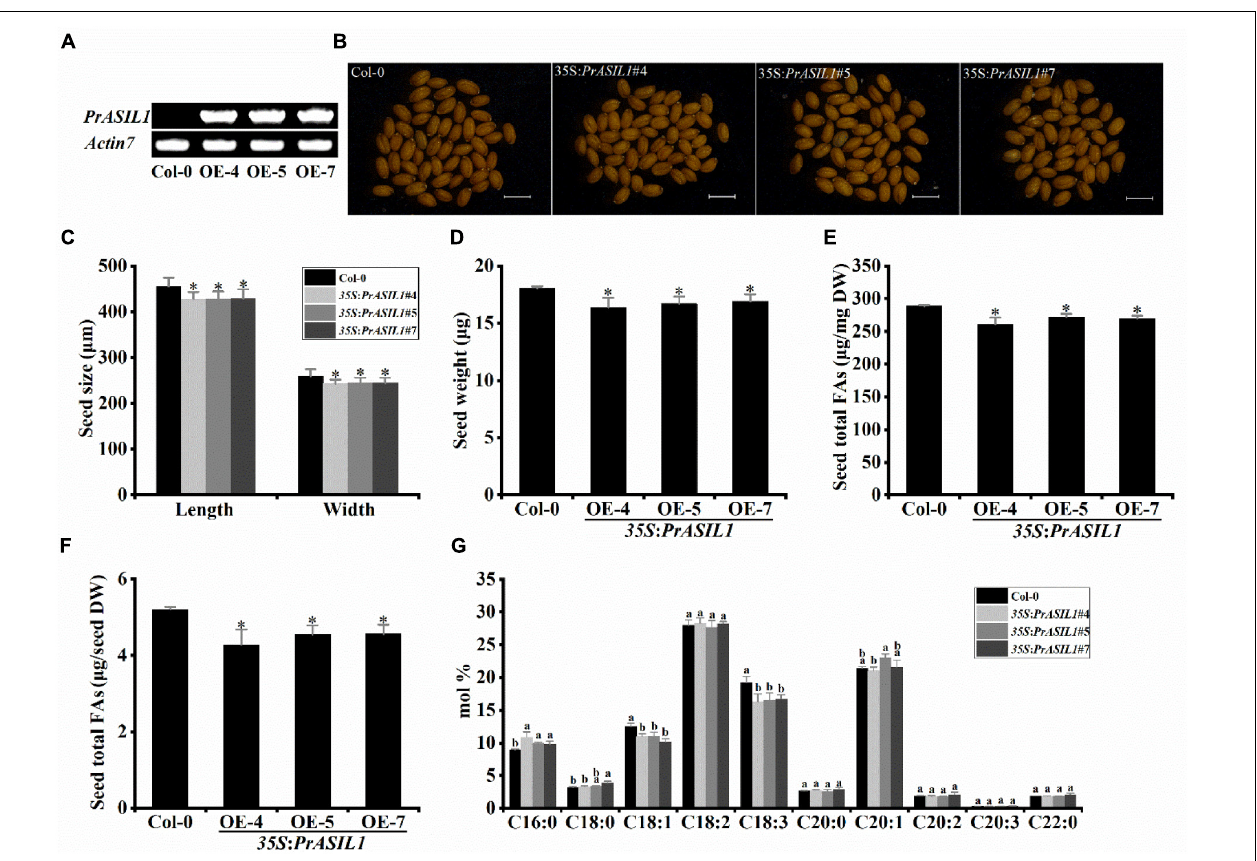
FIGURE 5 | Overexpression of PrASIL1 reduces seed oil content and alters FA composition in transgenic Arabidopsis. (A) RT-PCR analysis of PrASIL1 expressed in transgenic Arabidopsis seed. (B) Microscopic observation of mature seeds randomly collected from wild-type (Col-0) and PrASIL1 transgenic plants. Bars = 500 µ m. (C) Quantitative comparison of seed size (length and width) between the wild type (Col-0) and PrASIL1 transgenic plants. (D) Quantitative comparison of the dry weight of seeds between the wild type (Col-0) and PrASIL1 transgenic plants. (E) Comparison of total FA content ( µ g/mg) between the wild type (Col-0) and PrASIL1 transgenic plants. (F) Comparison of total FA content ( µ g/dry seed) between the wild type (Col-0) and PrASIL1 transgenic plants. (G) Fatty acid composition of wild type (Col-0) and PrASIL1 transgenic plants. DW, Dry weight. Values are means ± SD ( n = 3). Asterisks indicate significant differences in the seed size (C) , dry weight of seed (D) , seed total FA content (E,F) compared to that in the wild type (two-tailed paired Student’s t -test, P < 0.05). Different letters indicate significant difference in the contents of major seed FA compositions (G) compared to that in the wild type (one-way ANOVA with Tukey’s post-test, P <